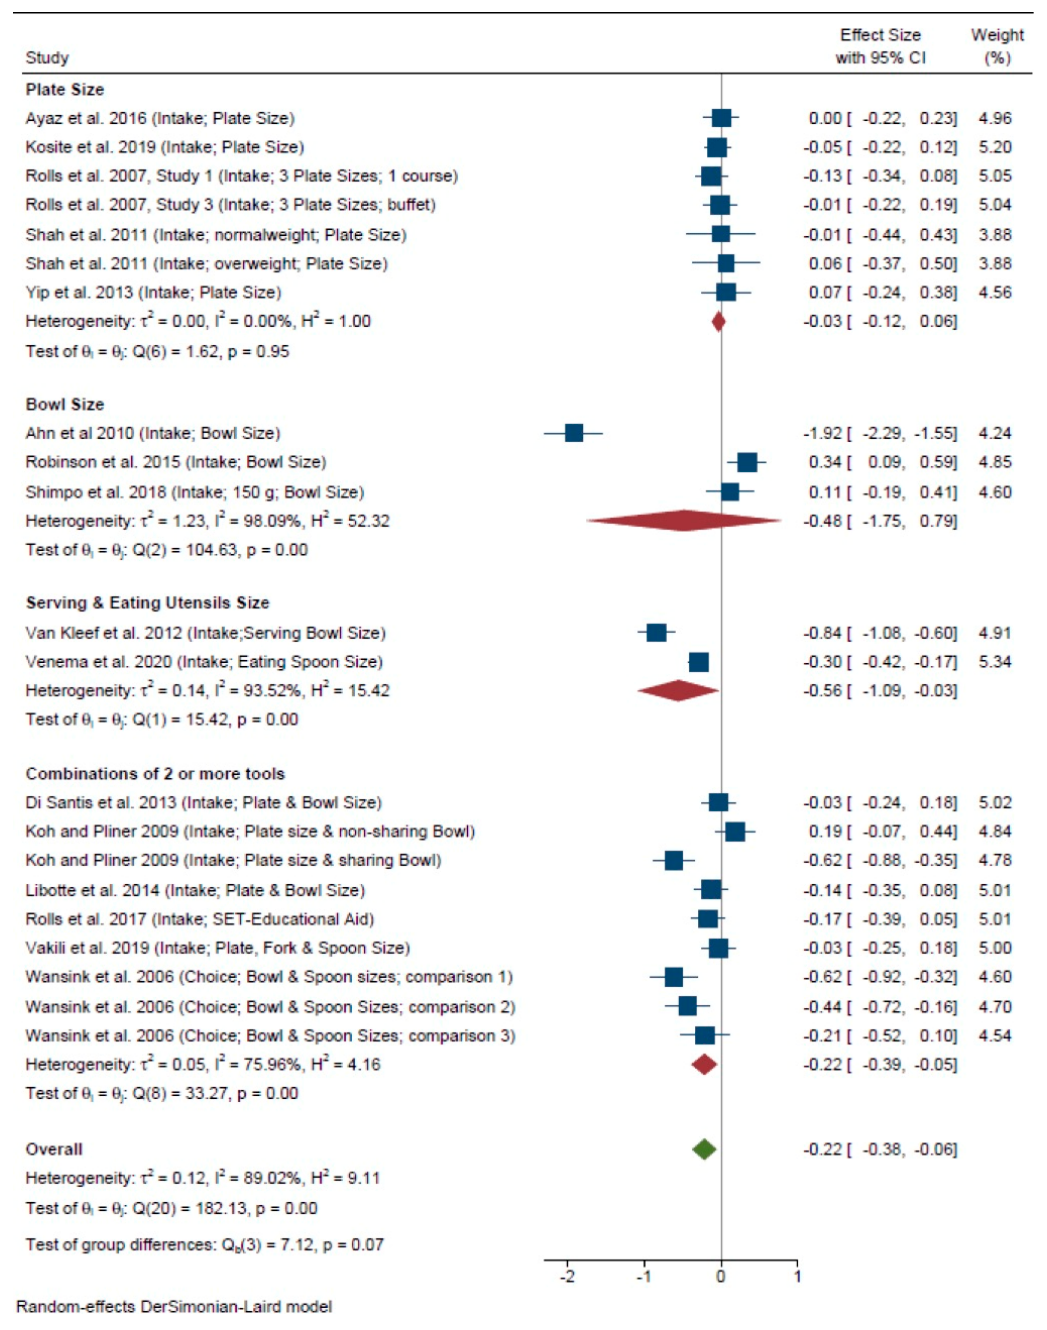
Figure 5. Forest plot for the analysis of all comparisons examining the effects of portion control tools on portion size intake (consumed amount) by tool type using a random-effects meta-analysis. Contributing comparisons are represented by a filled square with horizontal lines, where the area of the square depicts the contribution of the study to the full analysis, and the horizontal lines indicate the 95% CIs for each study. Studies displaced to the left of a 0 line demonstrate a finding in favor of the portion control tool to reduce food intake, whereas those to the right demonstrate a finding in favor of the portion control tool to increase consumed amounts when compared with the control condition. The diamond at the base of the plot represents the combined effect (Standardized Mean Difference) with 95% CIs. Wansink et al. 2006 Comparison 1—Small bowl combined with small spoon vs. Large bowl combined with large spoon. Wansink et al. 2006 Comparison 2—Small bowl combined with large spoon vs. Large bowl combined with large spoon. Wansink et al. 2006 Comparison 3—Large bowl combined with small spoon vs. Large bowl combined with large